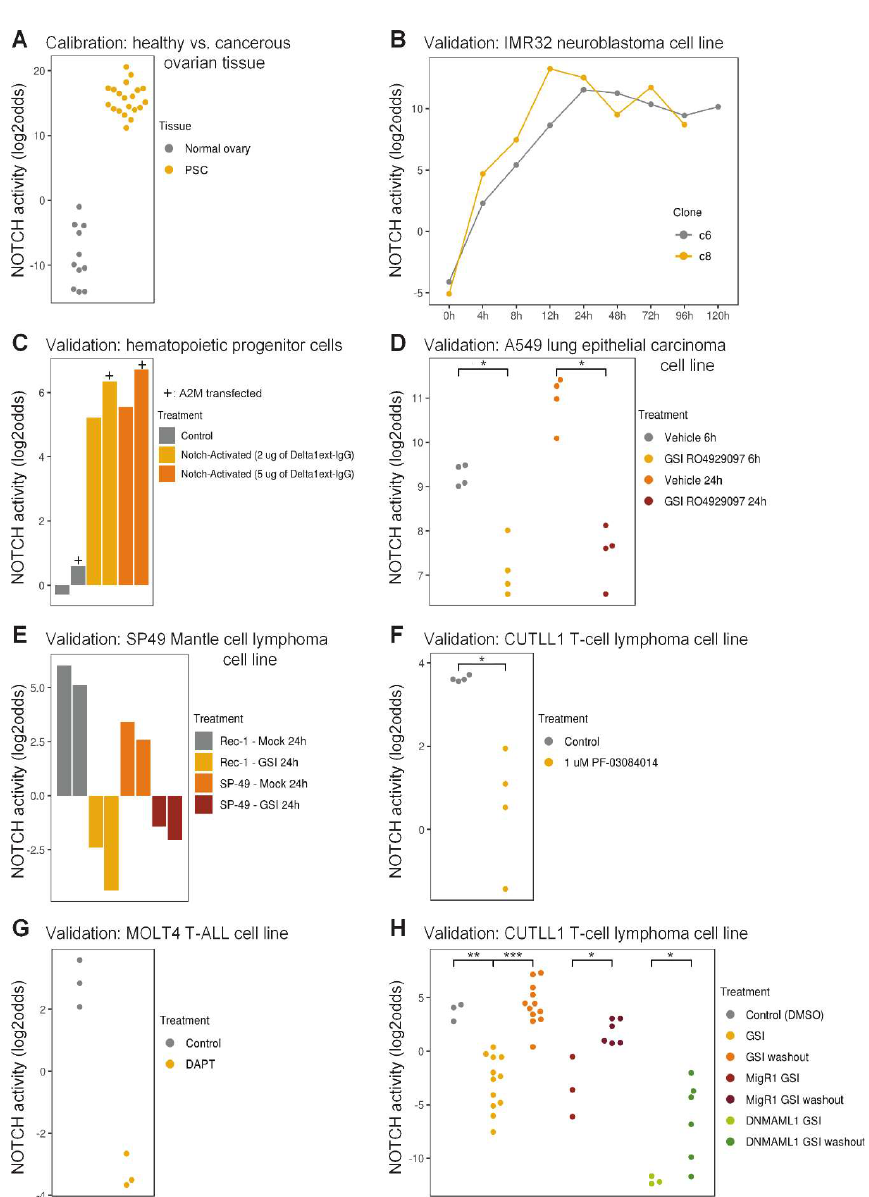
Figure 1. Calibration and biological validation of the Notch pathway model. ( A ) Calibration of the Notch pathway model. GSE7307, GSE18520 [90], GSE29450 [91], GSE36668 [92], normal ovarian tissue samples (inactive pathway); GSE2109, GSE9891 [93], high grade serous ovarian cancer samples (active pathway). ( B – G ) Validation of the model on independent GEO datasets from di ff erent cell lines. * p < 0.05, ** p < 0.01, *** p < 0.001. ( B ) GSE16477 [94]. Two clones (c6 and c8) of the IMR32 neuroblastoma cell line at di ff erent times (0–120 h) after induction of active intracellular NOTCH3. ( C ) GSE29524. A2M ( + symbol) or control vector-transfected CD34 + CD45RA - Lin - hematopoietic progenitor cells from umbilical cord blood were cultured for 72 h on a surface with 0, 2 or 5 µ g plastic-immobilized NOTCH ligand Delta1ext-IgG. A2M is a nuclear-trapped mutant of AF1q / MLLT11. ( D ) GSE36176 [95]. A549 lung cancer cell lines subjected to vehicle control or gamma secretase inhibitor (GSI) RO4929097 for 6 or 24 h. ( E ) GSE34602 [89]. Rec-1 (containing an activating NOTCH1 mutation) and SP49 Mantle cell lymphoma cell lines subjected to vehicle control or GSI compound E for 24